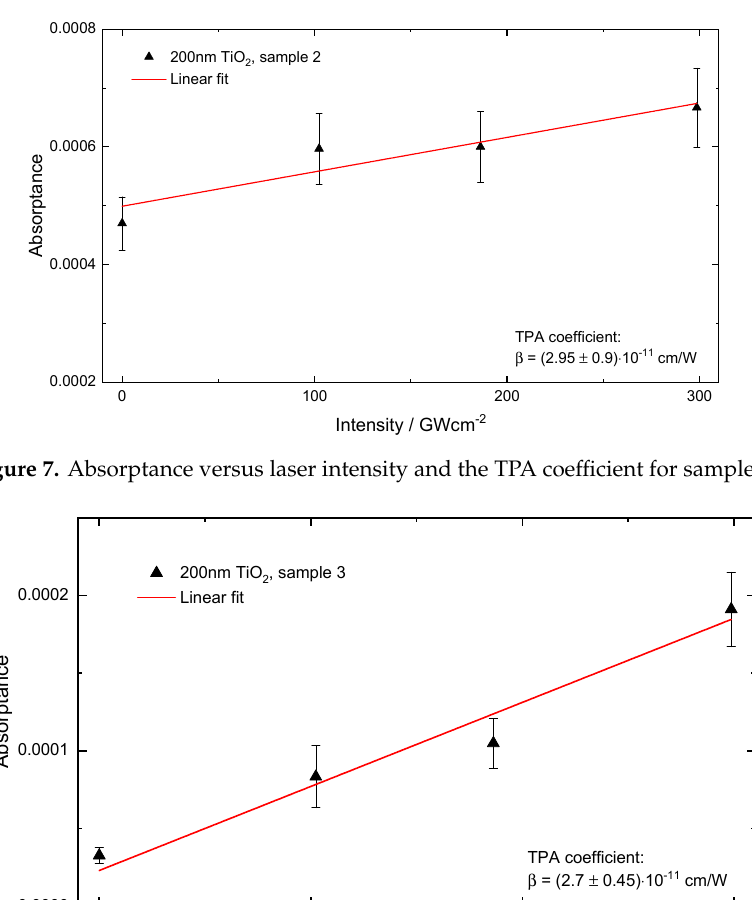
Figure 6. Absorptance versus laser intensity and the TPA coefficient for sample 1.